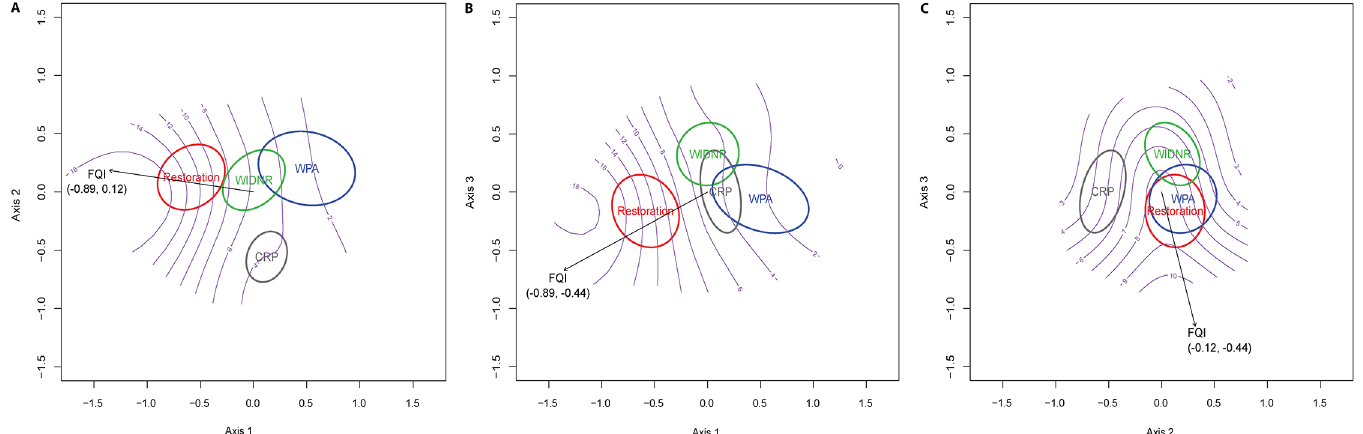
Fig 1. Nonmetric multi-dimensional scaling (NMS) biplots for vegetation in south-central Wisconsin prairies. A three axis solution best described the vegetation data: (A) axis 1 versus axis 2, (B) axis 1 versus axis 3, and (B) axis 2 versus axis 3. Ordination ellipses indicate planting type. Numbers under the environmental variable name represent the correlation with the horizontal and vertical axes of the respective plot. Purple gradients represent FQI scores.